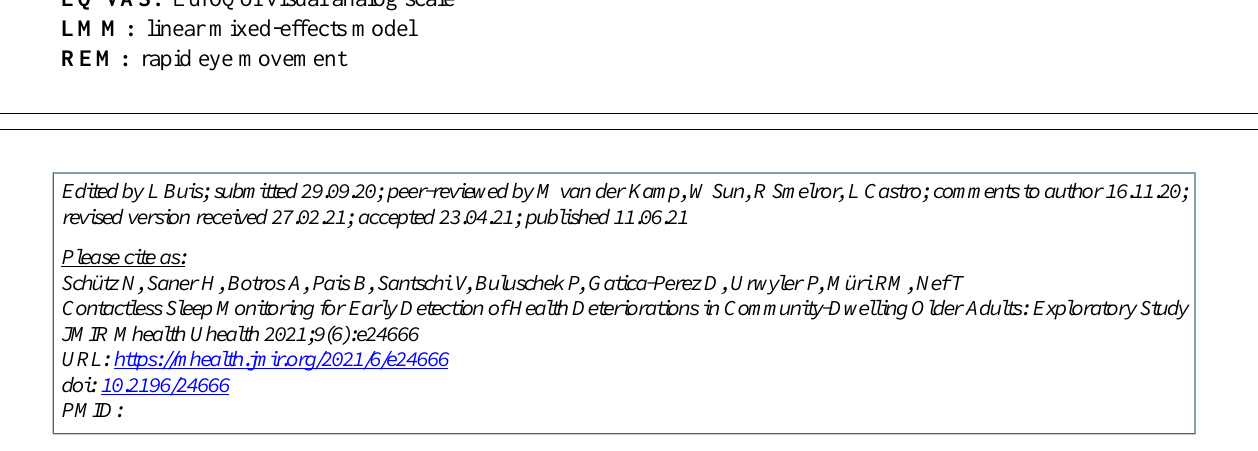
EQ-5D-3L: EuroQol health-related quality of life instrument EQ-VAS: EuroQol visual analog scale LMM: linear mixed-effects